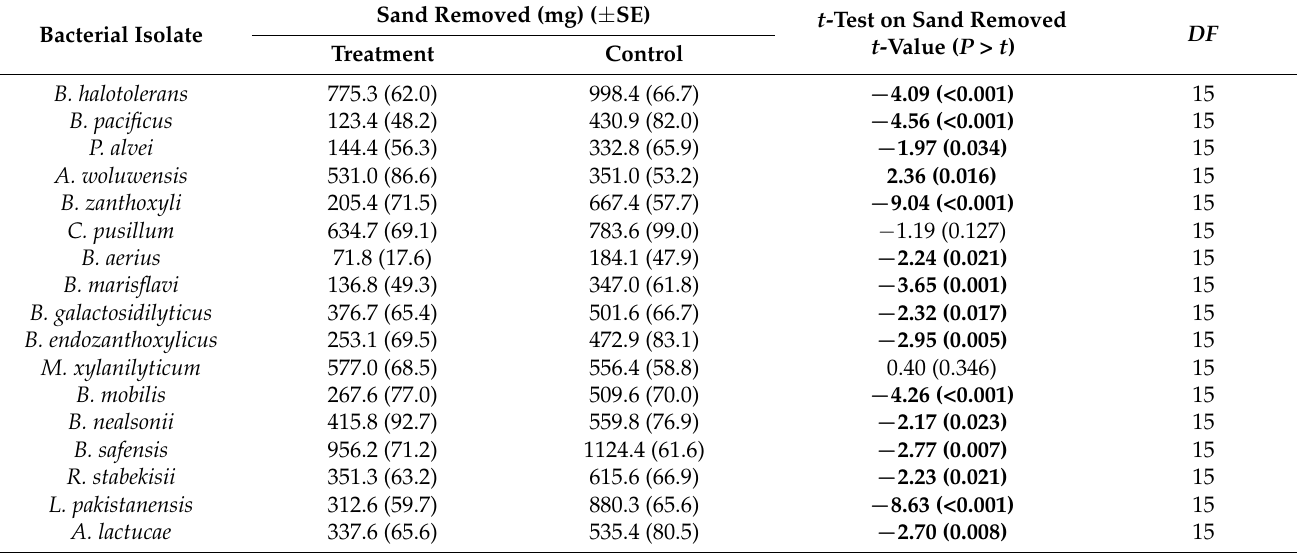
Table 3. Effects of soil-derived bacterial isolates on S. invicta digging preferences after 18 h. Bacterial